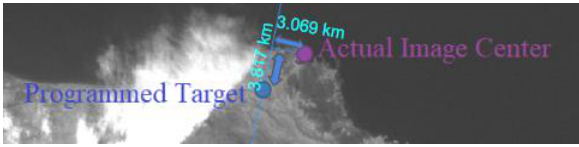
Figure 8. Muscat, Oman. Distance from programmed target to actual image center.